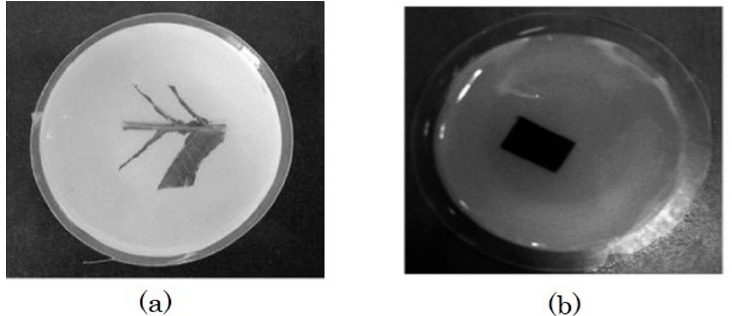
Figure 12. Pictures of the phantoms used in the experiments: ( a ) for the limited-angle circular scanning; and ( b ) for the straight-line scanning.